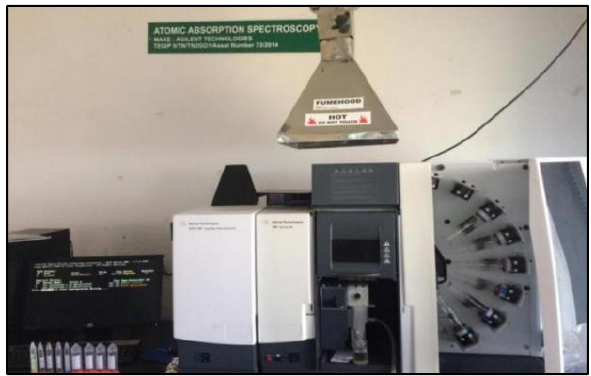
Figure 4. Atomic absorption spectroscopy.